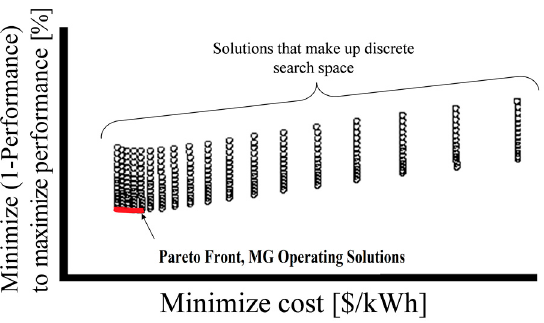
Figure 13. Discrete search space for pre-disturbance conditions. The objective functions (minimize cost and maximize performance) form the axes. Each circle represents a solution.